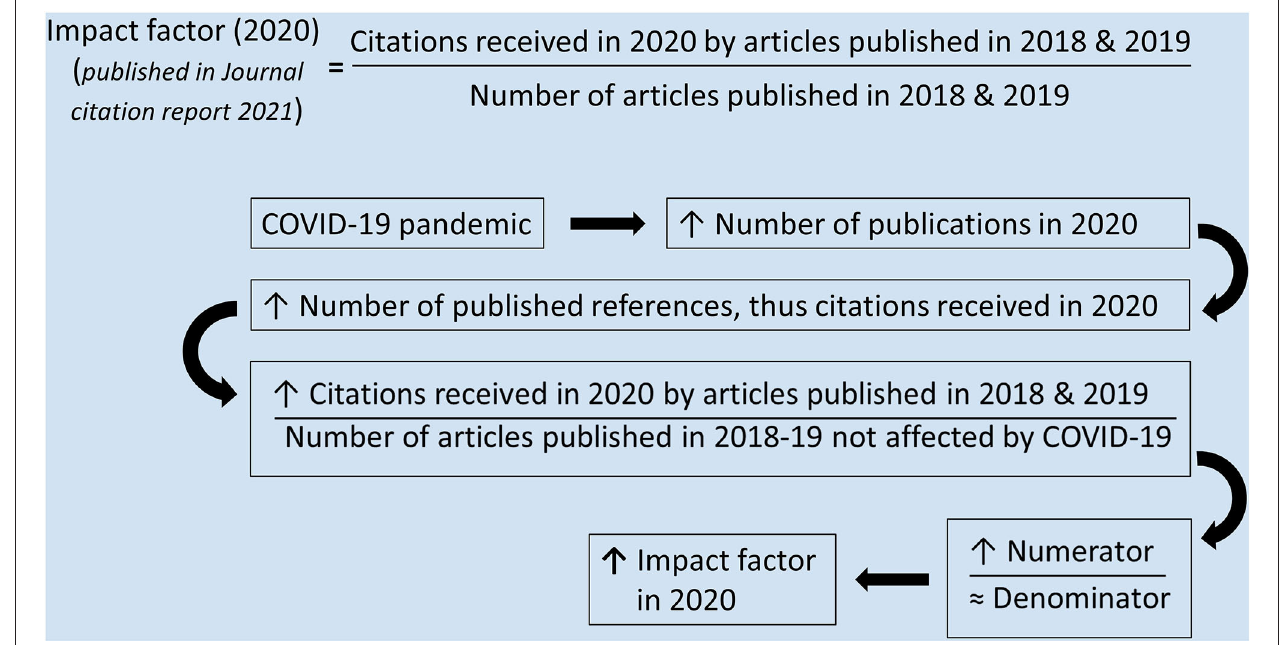
FIGURE 1 | The influence of COVID-19 outbreak on the upsurge of impact factors.